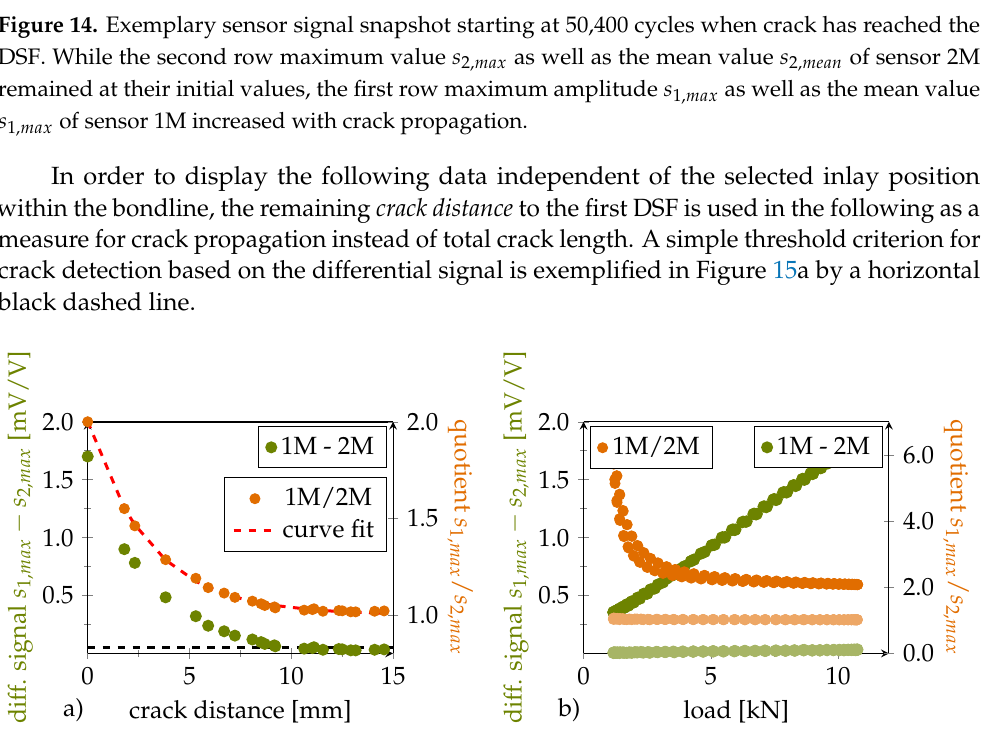
Figure 15. ( a ) Green curve corresponds to signal difference s 1, max s 2, max in dependence of crack − distance. The black dashed line on the bottom represents a crack detection threshold level of 0.05 mV/V. The orange curve corresponds to s 1, max / s 2, max and its fit forms the basis of the crack distance estimation algorithm. ( b ) Signal difference s 1, max s 2, max and signal ratio s 1, max / s 2, max in − dependence of load. Light green markers show the load independent initial differential relation (crack dist. = 15mm), darker green markers the linear relation after 50,400 cycles (crack dist. = 0mm). Same color wise allocation regarding crack distance was used for the orange quotient relation